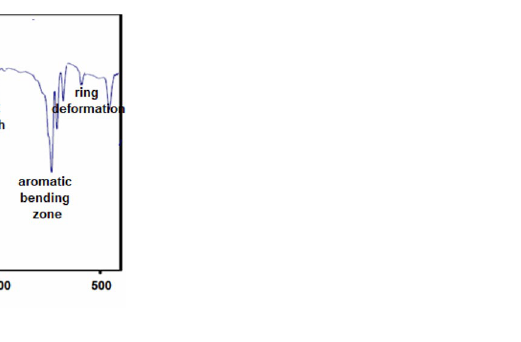
Figure 3. FT-IR spectrum of BLE